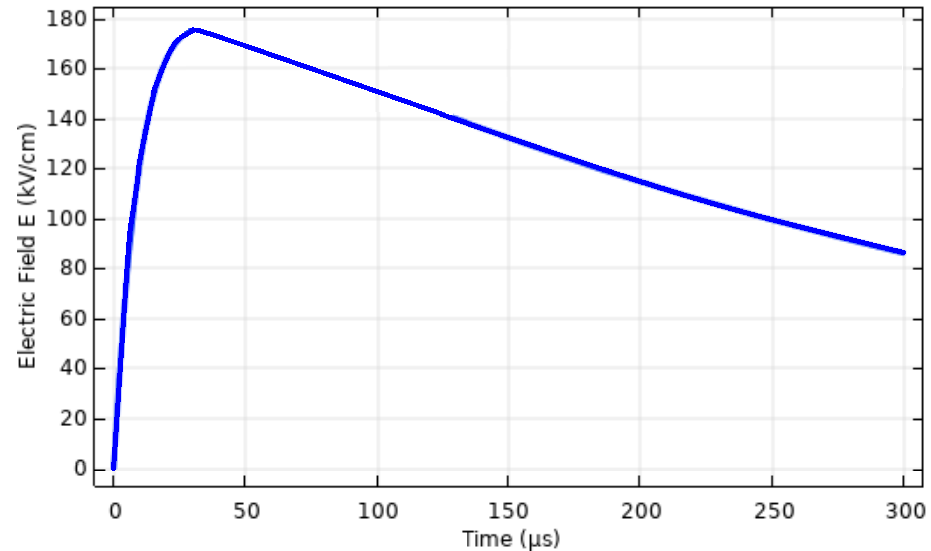
Figure 11. Electrical field on standard and add-on III LPS GRP.